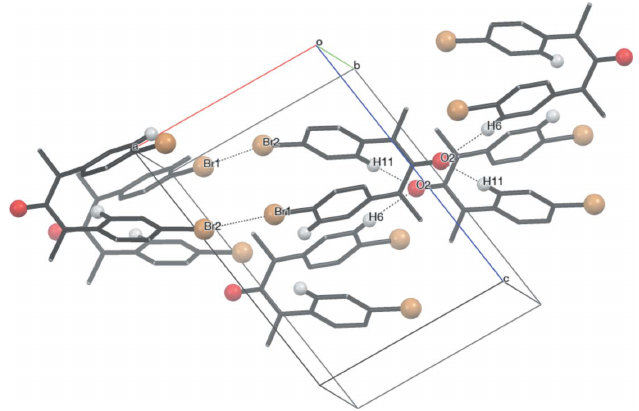
Figure 3 Chemical scheme showing the formation of the title compound from the corresponding Boc-protected aniline